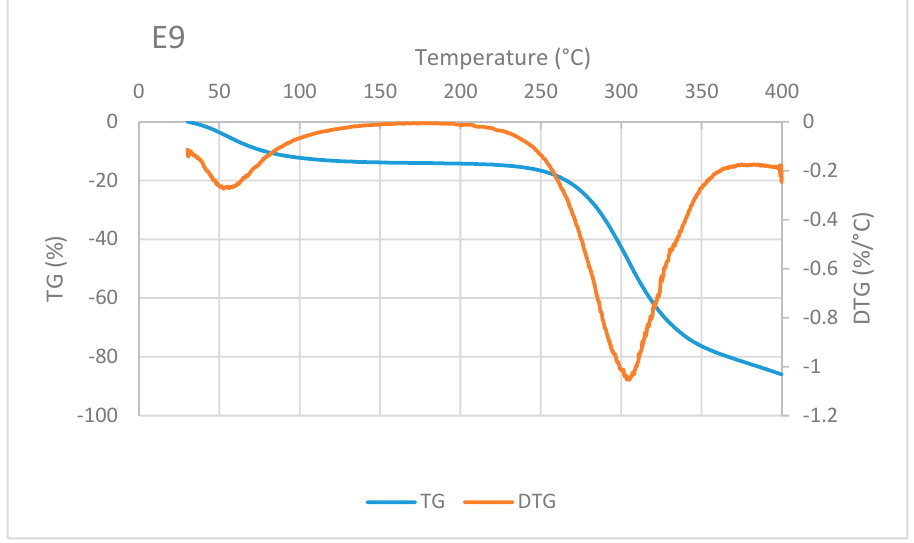
/ DTA curve of sago fiber-epoxy composite, taken from sample Figure 8. An example of TG/DTA curve of sago fiber-epoxy composite, taken from sample E9. Figure 8. An example of TG